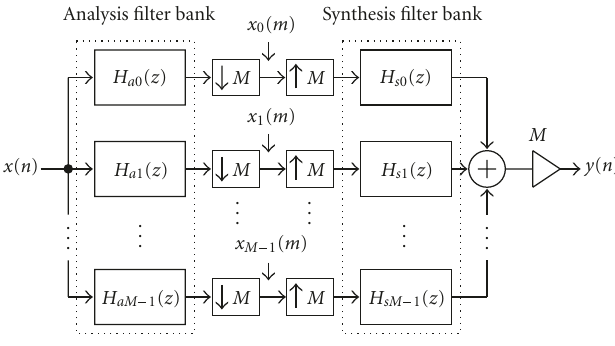
Figure 1: M -channel maximally decimated